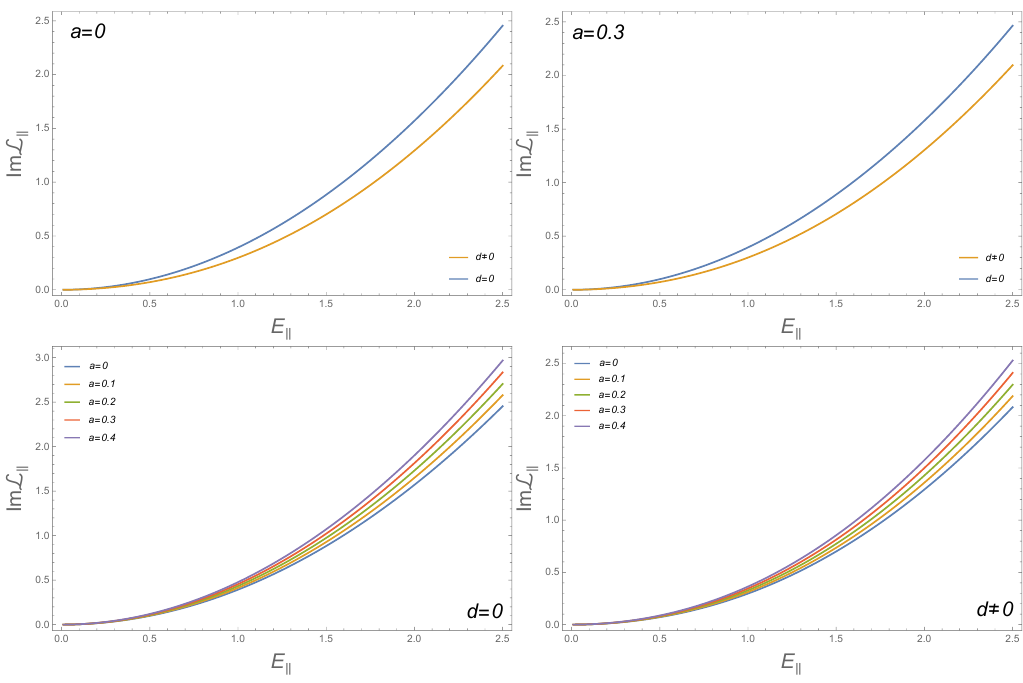
Figure 10 . The imaginary part of the Lagrangian L in the black brane background.